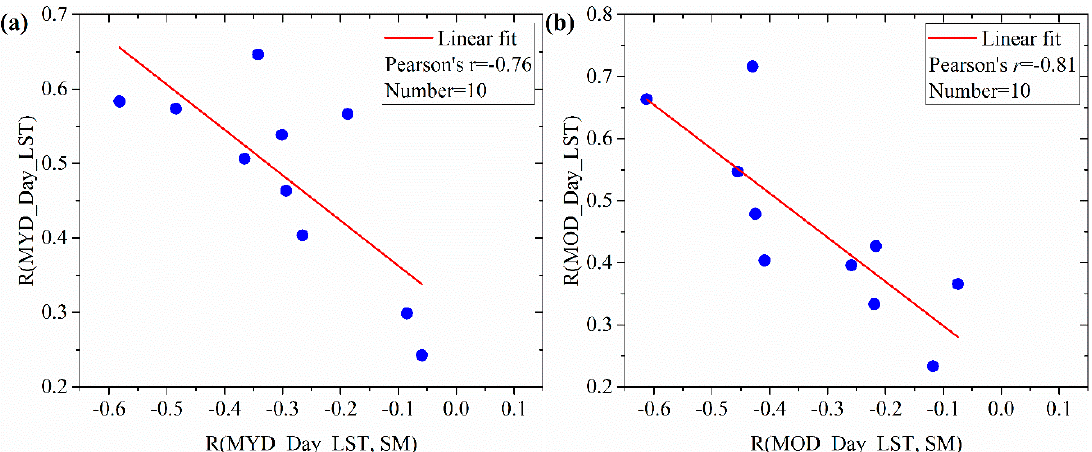
Figure 12. Evaluating the influence of LST-SM decoupling effect on the performance of LST as a downscaling factor. R(MYD_Day_LST, SM) and R(MOD_Day_LST, SM) are the Pearson correlations between daytime LSTs and SM. R(MYD_Day_LST) and R(MOD_Day_LST) are Pearson correlations between original SM and simulated SM based on the downscaling factors of MYD_Day_LST and MOD_Day_LST.